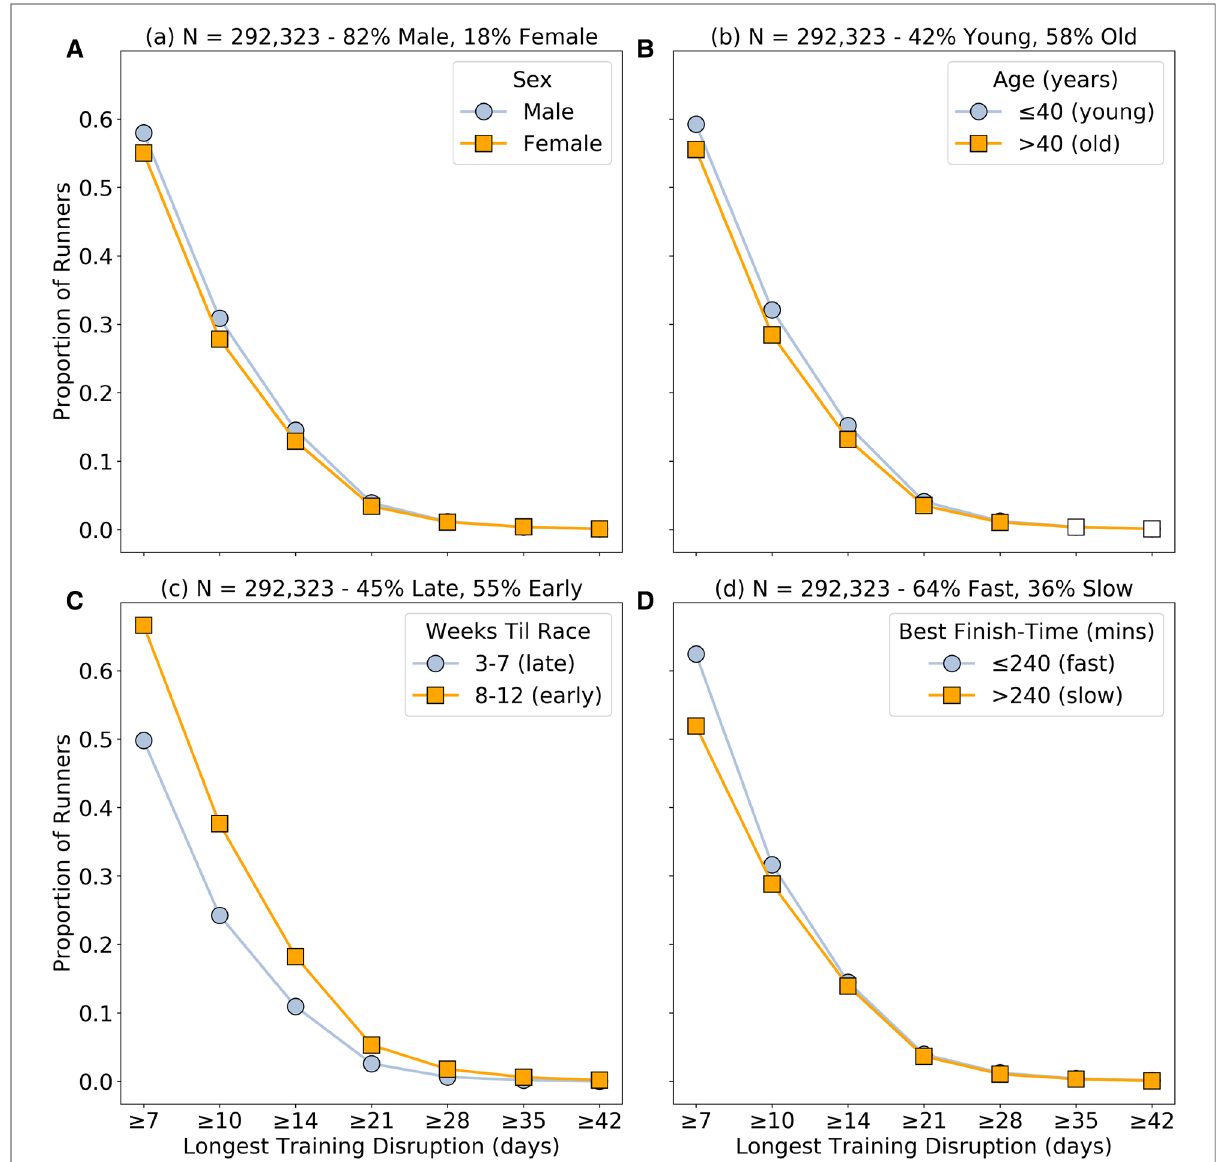
FIGURE 1 The cumulative proportion of runners experiencing progressively longer maximum training disruptions ( (cid:5) 7, 10, 14, 21, 28, 35, 42 days) based on: ( A ) sex (male versus female); ( B ) age ( (cid:2) 40 years-old vs >40 years-old); ( C ) timing (early or late in training); and ( D ) runner ability (based on whether their fastest marathon was faster, (cid:2) 240min, or slower, (cid:5) 240min). The statistical signi fi cance of the difference in proportions between each group, for a given longest disruption length, is calculated based on a two-proportion z -test with p , 0 : 01 and indicated by fi lled ( p , 0 : 01) or un fi lled ( p (cid:5) 0 : 01)